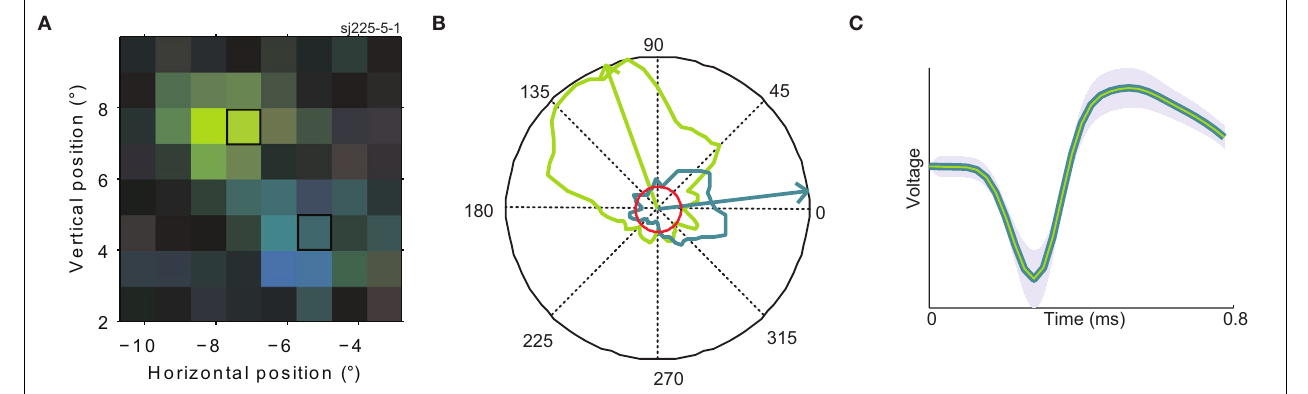
featureless gray screen (background firing rate). Arrows represent the circular mean of the firing rate distributions; i.e., the preferred direction per patch. (C) Average spike waveforms evoked by stimulation of each of the patches (in colors matching the preferred direction).The green curve is deliberately thinner to make both, nearly identical waveforms visible.The shaded area represents one standard deviation.These analyses show that preferred direction changes within the RF of MT neurons are not caused by interactions due to the complex motion stimulus, but occur even for single dots moving within the RF of a single well-isolated neuron.